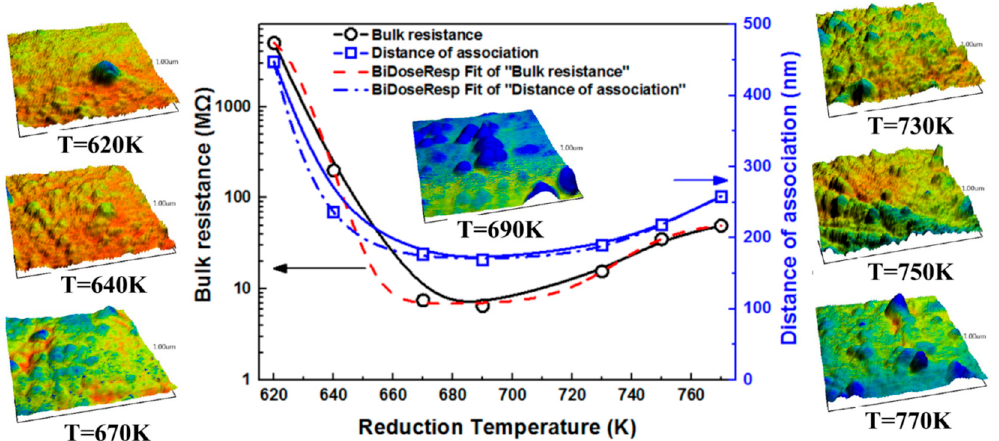
Figure 8. Profiles and fitting charts of the reduction temperature to the distance of [Pb] atom aggregates at the reduced temperature from 620K to 770K. The 3D-mixed tomography of AFM and KFM for silicate glass at each reduced temperature is shown in Figure 7, displaying temperature dependence and nanoparticle-spacing dependence of resistivity of lead silicate glass MCPs.